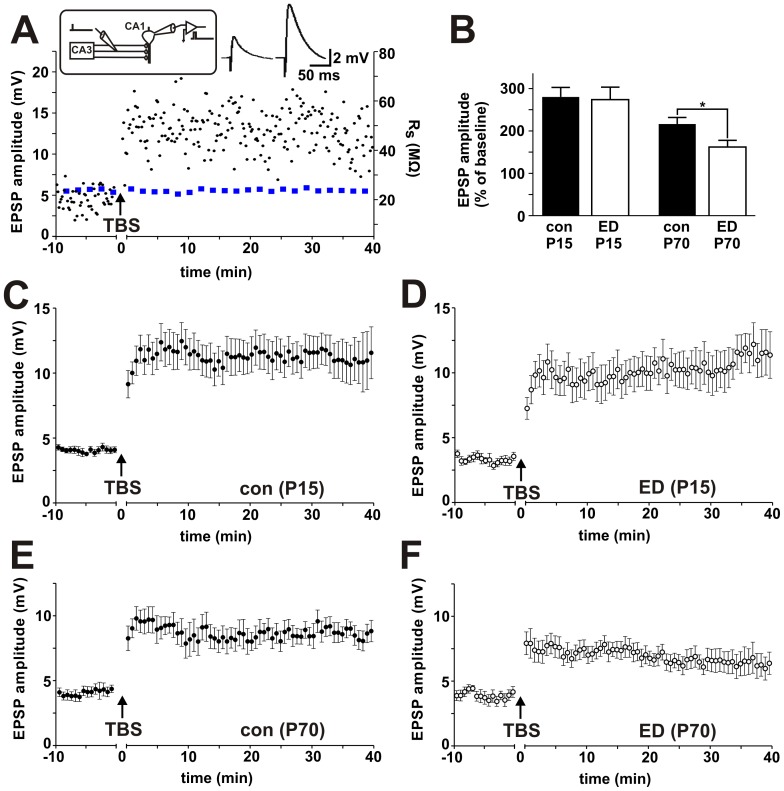
Theta-burst LTP is impaired in adult animals after early deprivation.
(A) Whole-cell patch clamp recordings were made from CA1 pyramidal neurons in hippocampal brain slices. EPSPs were induced by current stimulation of the Schaffer collateral pathway. A typical single experiment from a non-stressed mouse is shown. Dots represent maximal EPSP amplitudes (left axis). Blue squares indicate series resistance (Rs, MΩ, right axis). At the time indicated by an arrow, LTP was induced by theta-burst stimulation (TBS), with 125 EPSP-AP pairings. This resulted in stable LTP. (B) Averaged effect of TBS-LTP in different experimental groups. Effect of TBS-LTP in control animals at P15 (n = 18, C); after ED at P15 (n = 12, D); in control animals at P70 (n = 9, E); and after ED at P70 (n = 11, F). All error bars represent SEM.